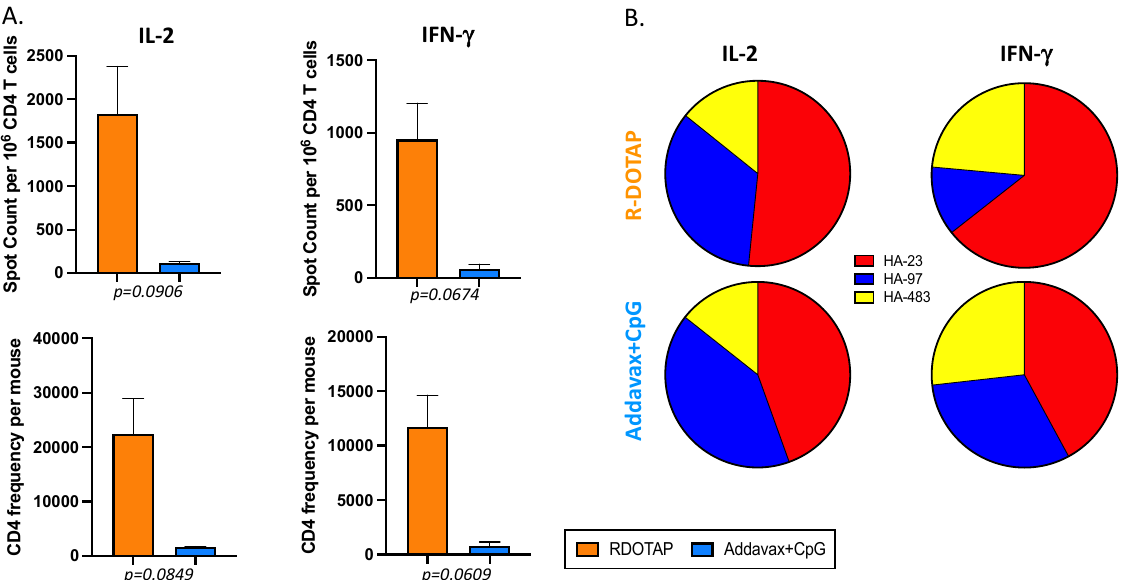
Figure 5. CD4 T cell response following intramuscular vaccination with HA-B. Mice (3–4 per group per experiment) were immunized intramuscularly with HA B/Malaysia in adjuvant and spleens were harvested at day 10/11 post vaccination and used as a source of CD4 T cells, enriched by depletion of other subsets of cells. Panel ( A ). The magnitude of the response in the spleen detected by IL-2 and IFN- γ ELISpot. The top plots show the frequency of cytokine producing CD4 cells per million and the bottom groups illustrate the cytokine producing cells calculated per mouse. All data have been corrected for background. Shown is the average of three independent experiments and the standard error of the mean. Below each plot is the p -value calculated using an unpaired t-test with Welch’s correction. Panel ( B ). Pie diagrams illustrating the fraction of the response dedicated to each of the HA peptide epitopes that were tested, with R-DOTAP on the top and Addavax + CpG on the bottom. The cytokine detected is indicated above. Shown is the average of three independent experiments. There was no statistical difference detected between the adjuvant systems.